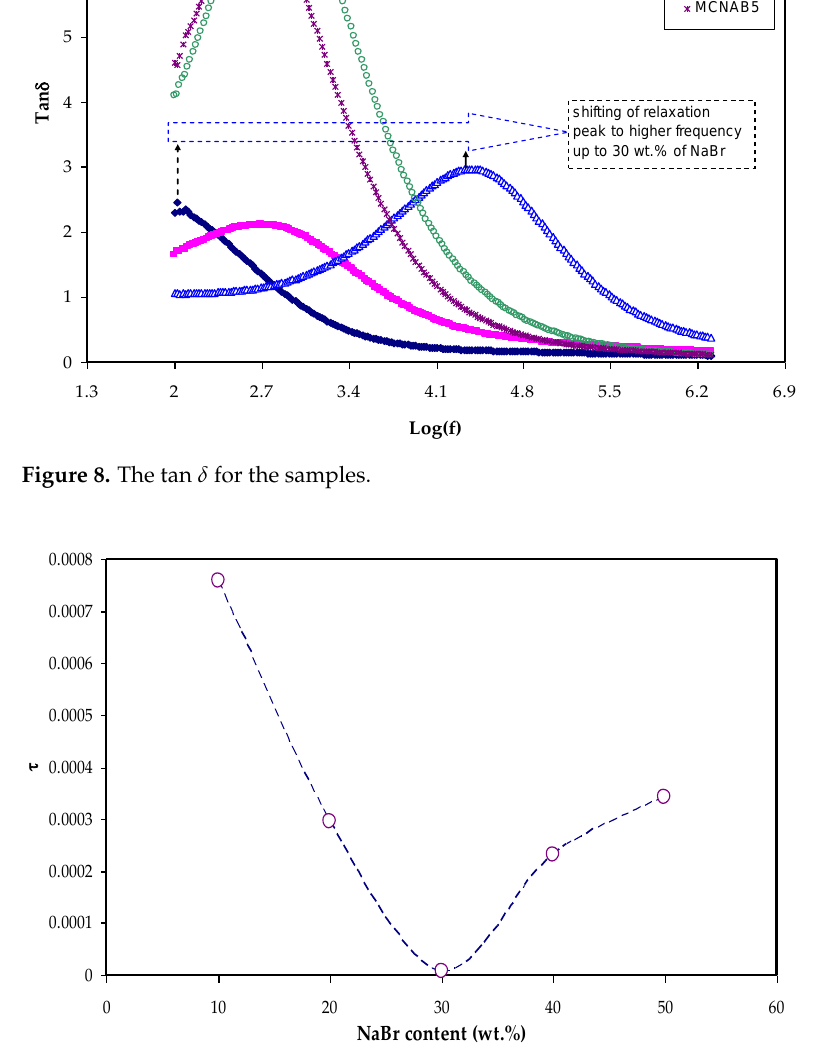
Figure 9. Relaxation time vs. NaBr concentration.